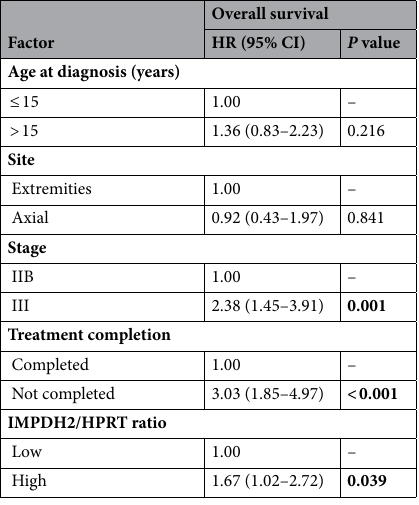
Table 5. Multivariate analysis of factors associated with overall survival in osteosarcoma with inclusion of IMPDH2/HPRT